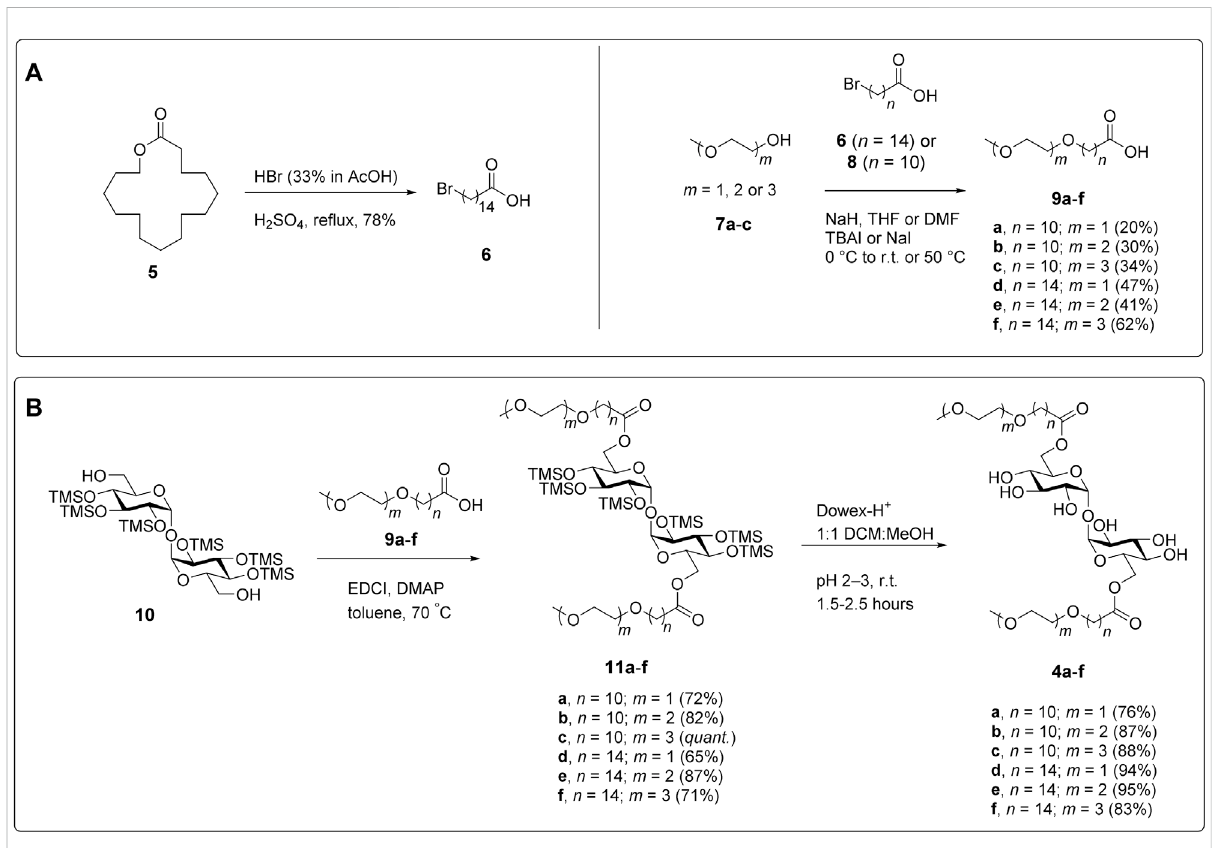
FIGURE 3 Synthesis of PEG-TGLs. (A) Preparation of the carboxylic acids required to install the PEGylated side chain. (B) Conjugation of the suitably functionalized trehalose scaffold (Khan et al., 2011) to the carboxylic acid side chains and deprotection to give the target PEG-TGLs ( 4a-f